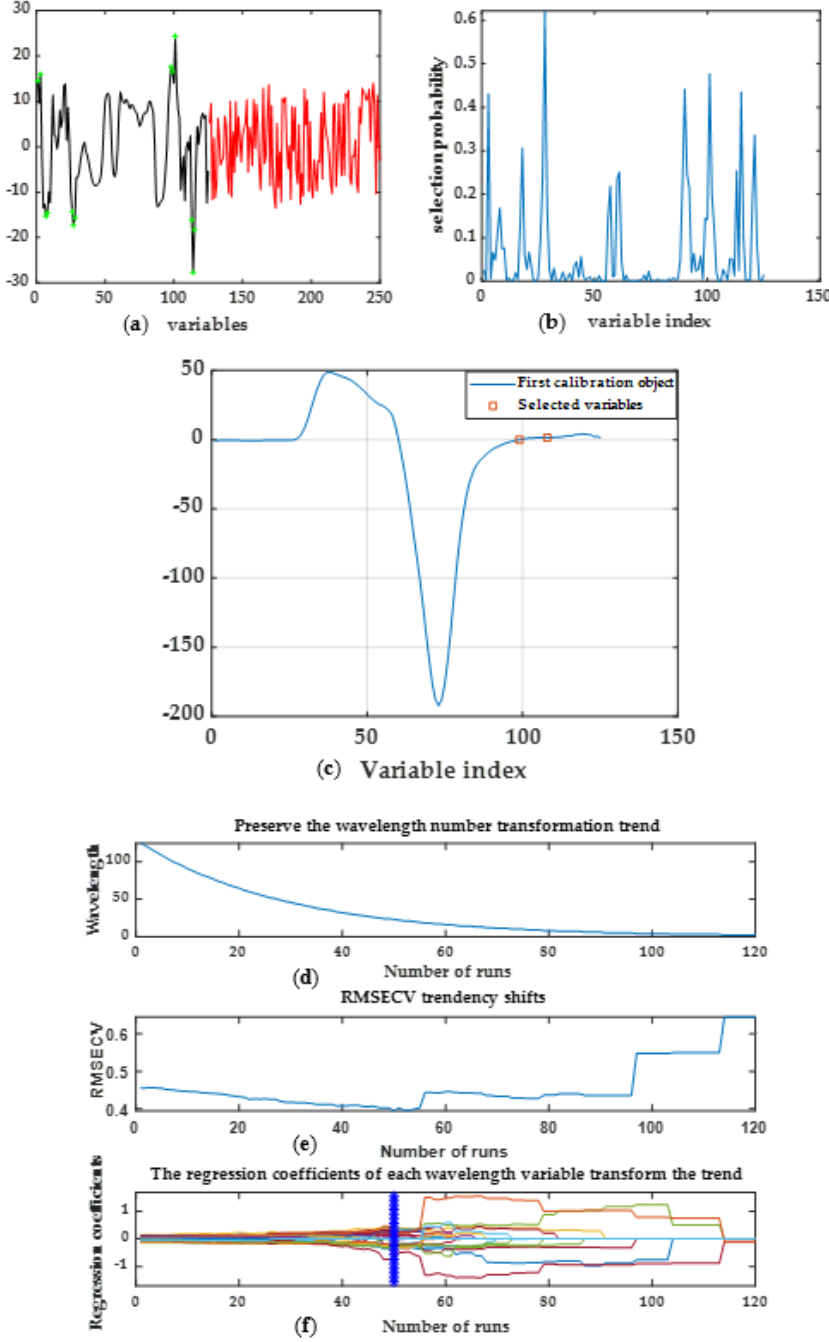
Figure 6. ( a ) The extraction process of UVE; ( b ) The extraction process of RF; ( c ) The extraction process of SPA; ( d ) preserve the wavelength number transformation trend; ( e ) RMSECV tendency shifts; ( f ) number of